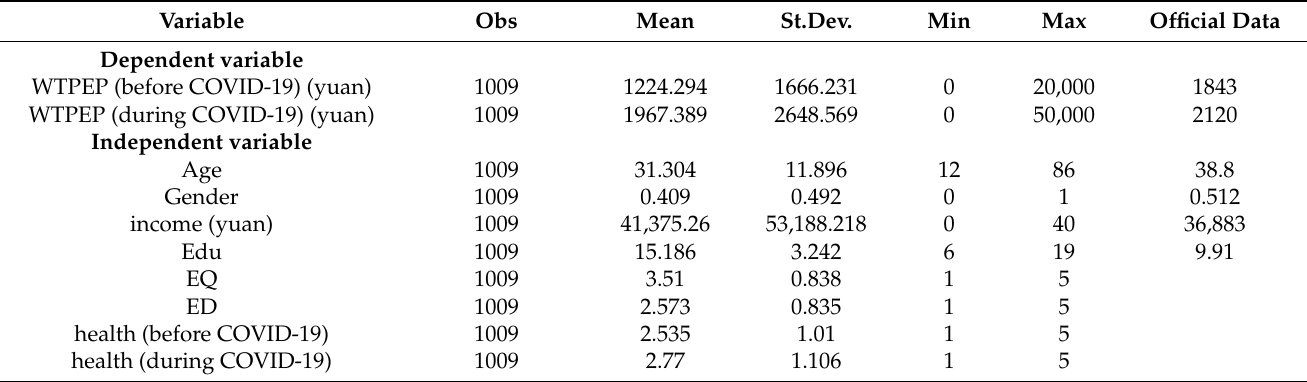
Table 2. Descriptive statistics of